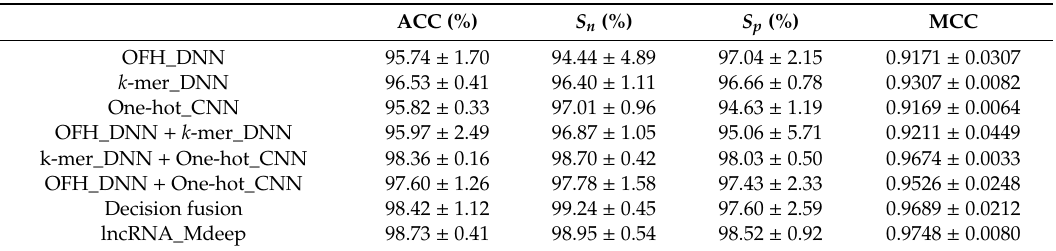
Table 1. Performance of lncRNA_Mdeep and other model architectures in the 10CV test.